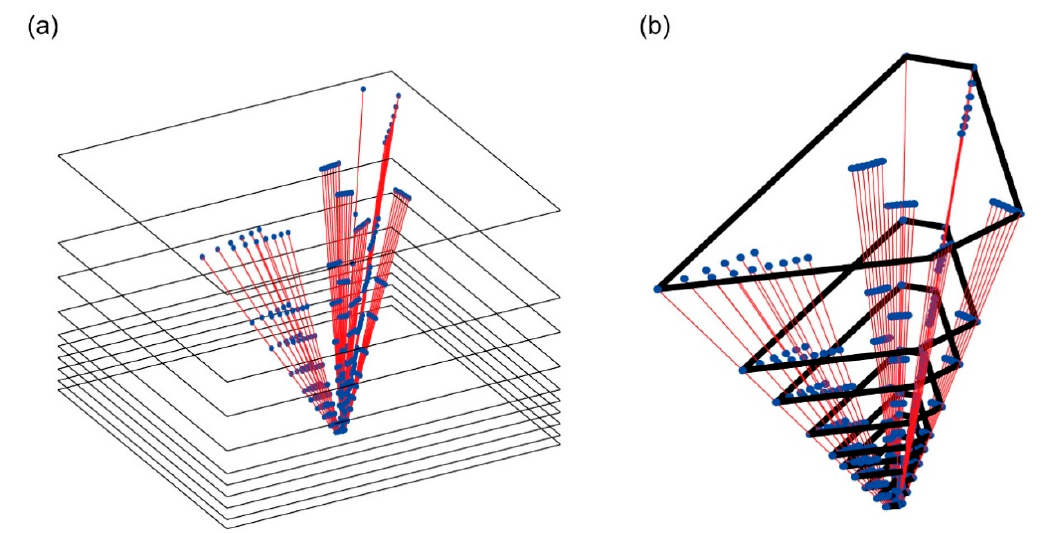
Figure 3. Determination of the tomographic region; ( a ) A set of satellite signals (red lines) used in single-station tomographic modeling and their intersections (blue points) with all horizontal planes; ( b ) Tomographic boundary on every horizontal plane is formed by the black loop obtained based on the Graham scan.